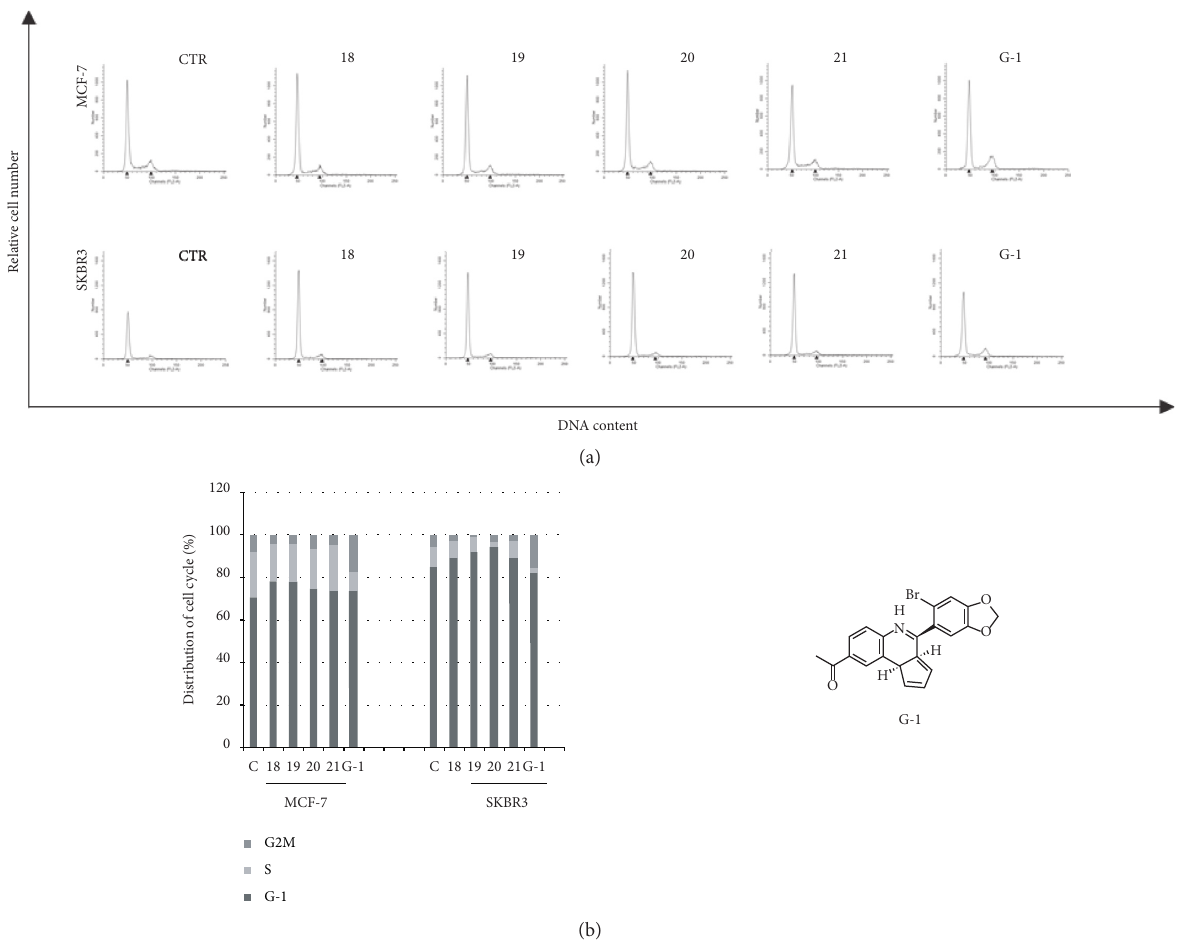
Figure 4: Effects of compounds 18, 19, 20, 21, and G-1 on cell cycle distribution in breast cancer cells. (a) MCF-7 and SKBR3 cells treated with 1 μ M of compounds as indicated for 48h, stained with propidium iodide (PI), and analyzed on a FACScan flow cytometer. (b) Quantitative analysis of percentage gated cells at G1, S, and G2/M phases were